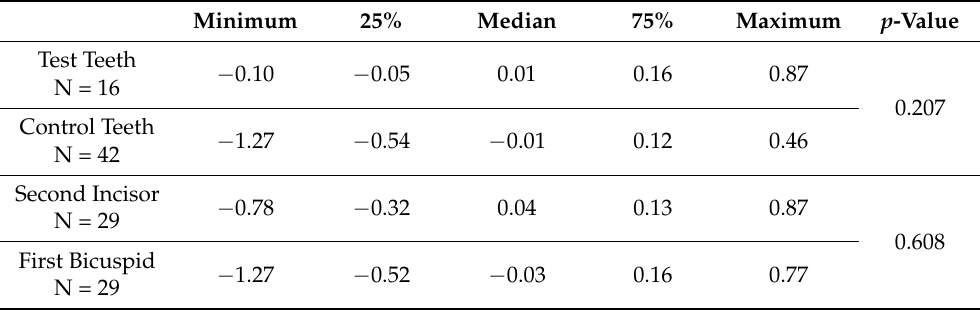
Table 2. Differences over time in the root length of adjacent teeth (mm, N = 58); p -value = Mann– Whitney U test adjusted using the Bonferroni